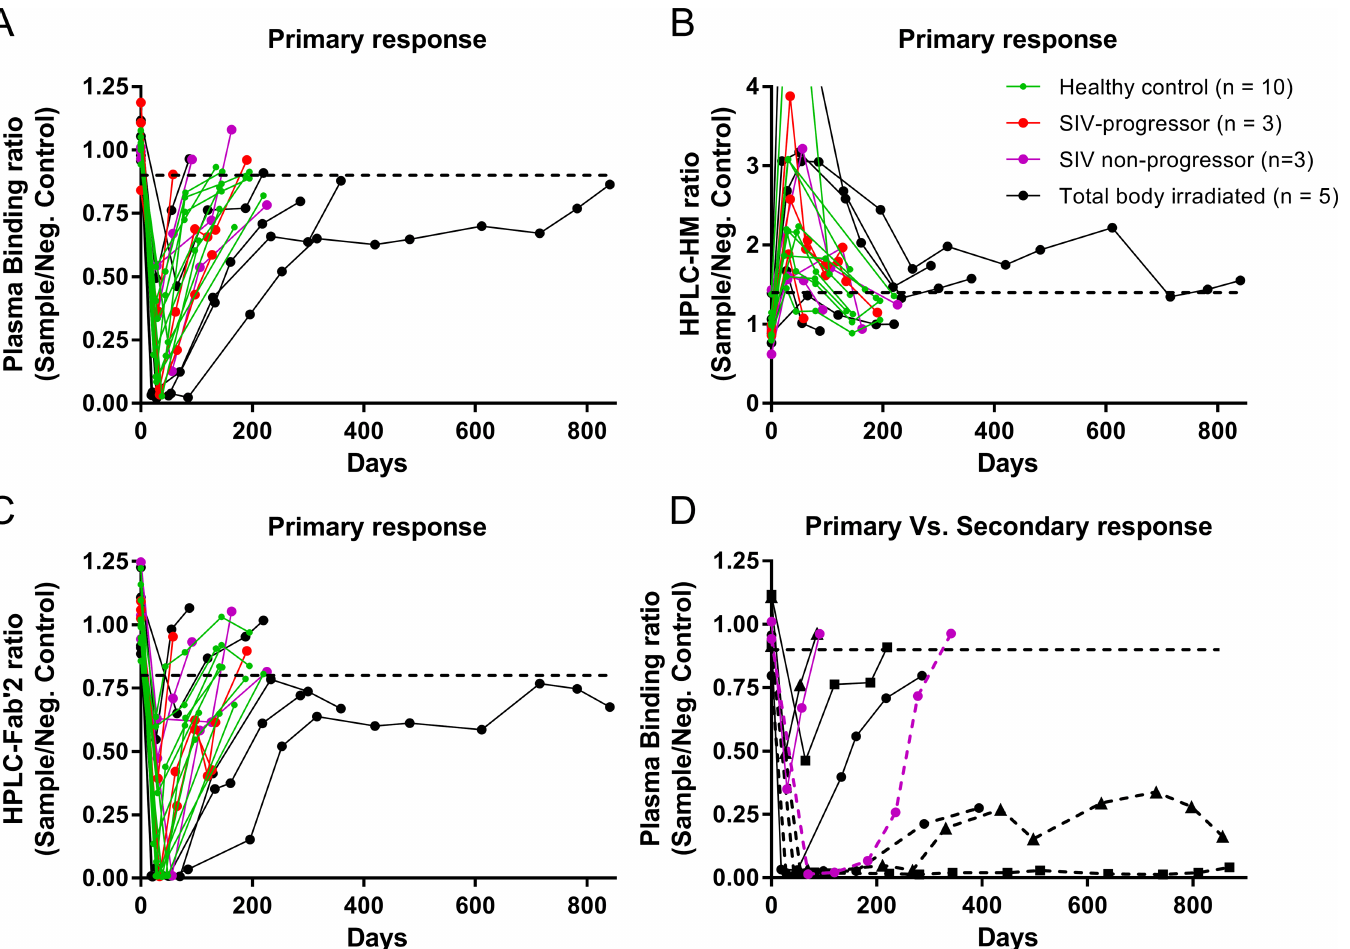
Fig 3. Clearance of endogeneous anti-tracerantibody (ATA). Anti-tracer antibody clearance from primary responsein 10 healthy uninfectedcontrols (green solid), 3 SIV-progressors (red solid), 3 SIV non-progressors (purplesolid), and 5 total body irradiated(black solid) rhesus macaquesfrom (A) plasma bindingassay, and (B) (C) radio-HPLCimmunogenicity assay using F(ab 0 ) 2 -CD4R1antibody.(D) shows clearance of anti-tracer antibody from primary and secondary responses in one SIV non-progressor (purple) and 3 total body irradiated(black) rhesus macaquesusing plasma bindingassay where solid lines indicateATA clearancefrom primary response, and dashedlines indicateATA clearancefrom secondary response. Day 0 indicatesthe radiotracerexposure.